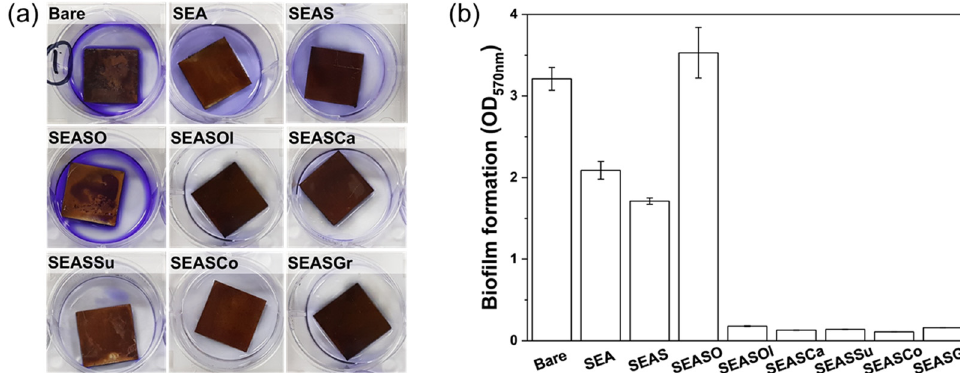
Figure 5. ( a ) Images of dyed solution with sample and ( b ) optical density of dyed Pseudomonas aeruginosa .